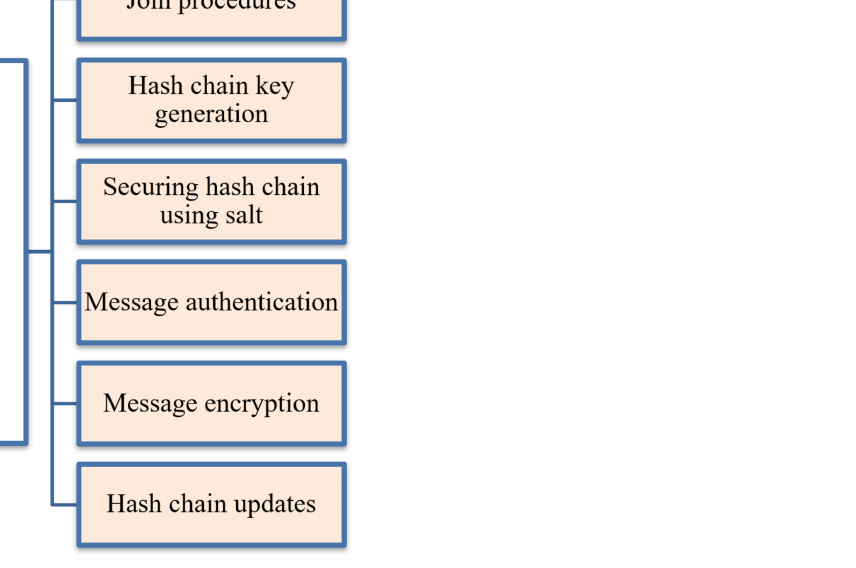
Figure 5. The proposed protocol